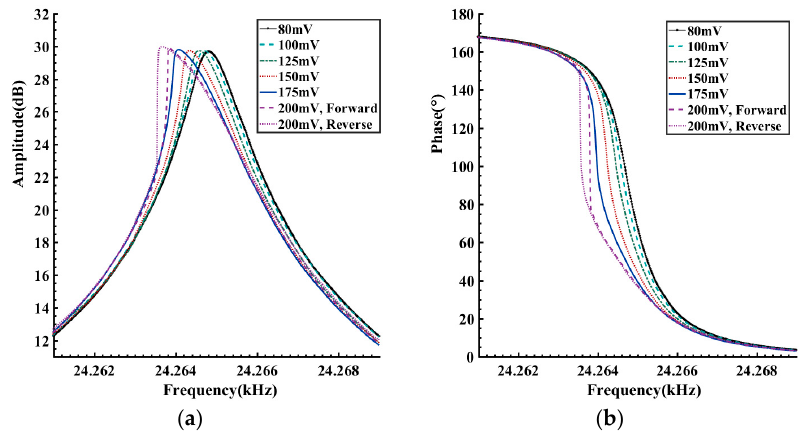
Figure 13. Frequency response curves obtained by frequency sweeping: ( a ) Amplitude-frequency curves; ( b ) Phase-frequency curves.